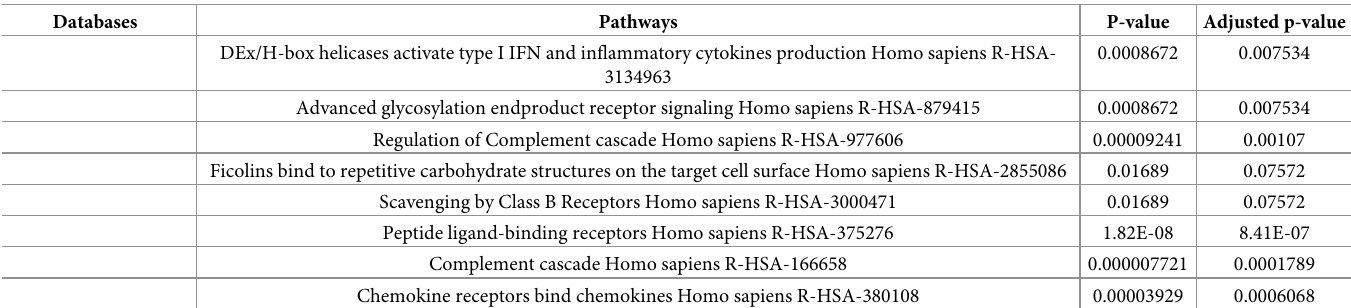
highlighted in the module network of common up-regulated DEGs (UP-Module analysis net- work). SIGLEC7 is the gene highlighted in the module network of common down-regulated DEGs (DOWN-Module analysis network). Module analysis is shown in Fig 6. The UP-Module analysis network contains 11 nodes and 37 edges. The DOWN-Module analysis network